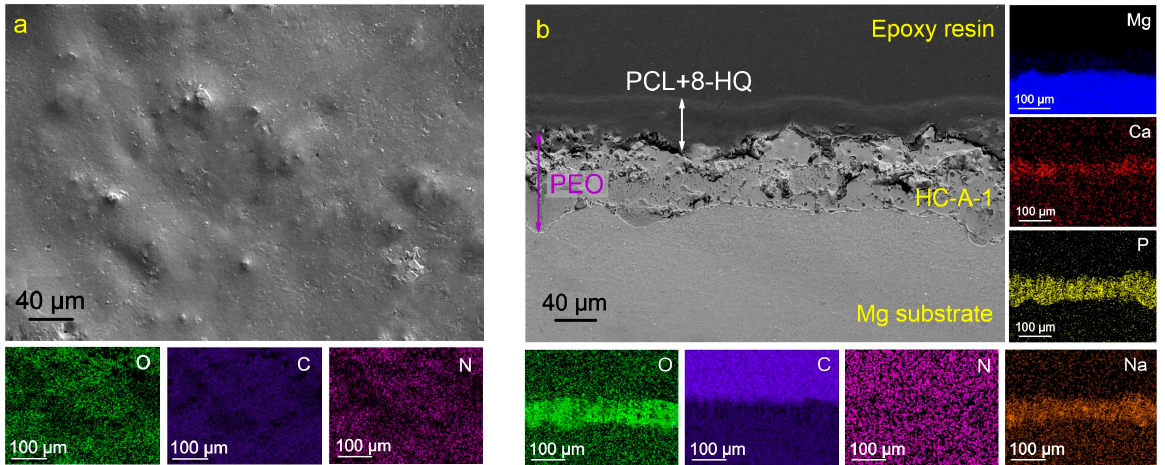
Figure 6. SEM images of the surface ( a ) and cross-section ( b ) of the HC-A-1-coated samples and maps of elements distribution over the sample’s surface ( a ) and thickness ( b ).